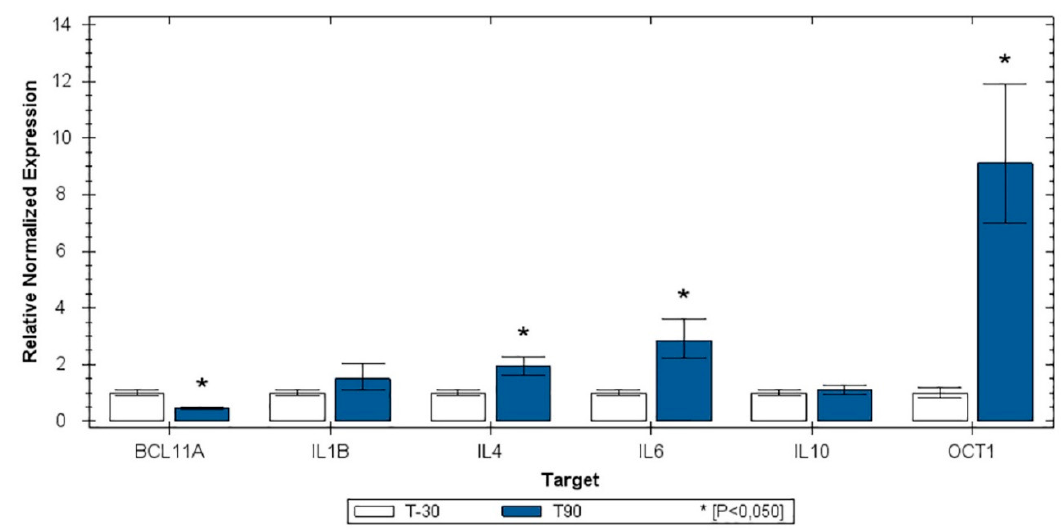
Figure 3. Histogram representing the relative expression values for T-30 and T90 for the investigated genes.